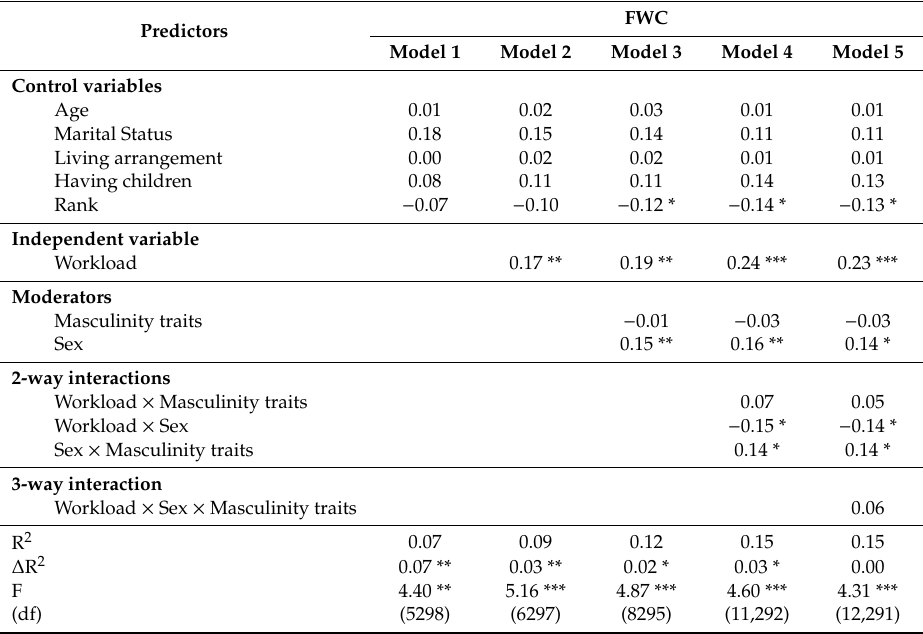
Table 2. Results of moderated regression on family-to-work conflict (FWC): masculinity traits. Predictors